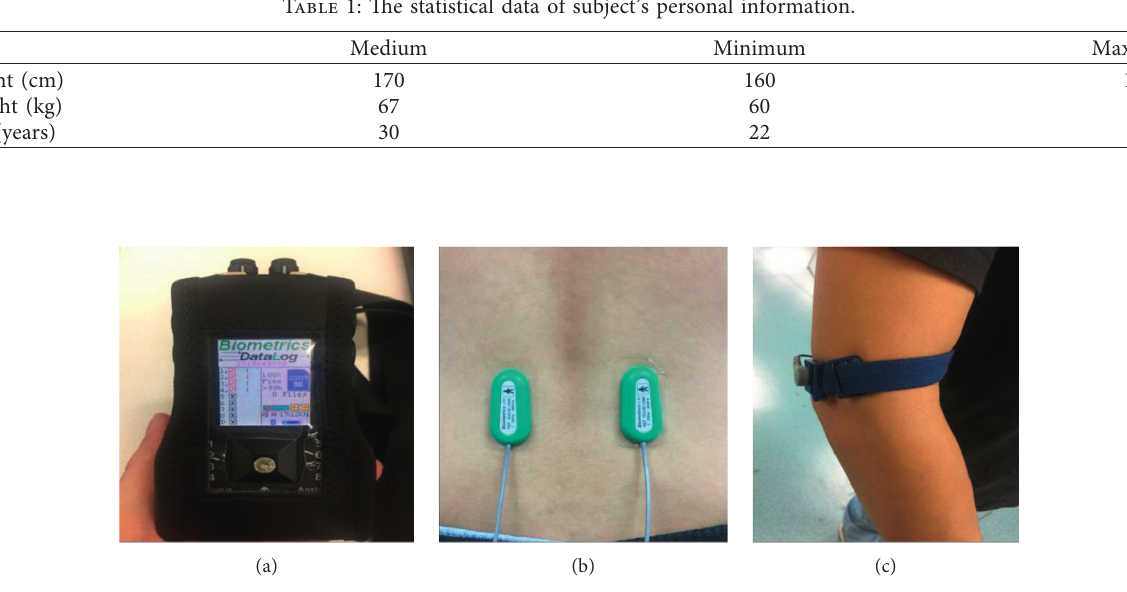
Figure 9: Testing equipment and testing lumbar position. (a) The surface EMG sensor (SX230) of Biometrics Ltd; (b) the position of EMG sensors; (c) the reference electrode position.